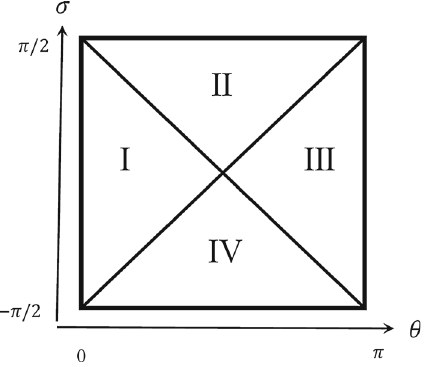
Fig. 1 Penrose diagram for dS 2 . The conformal coordinates (σ,θ) cover the whole region, regions I, II, III, and